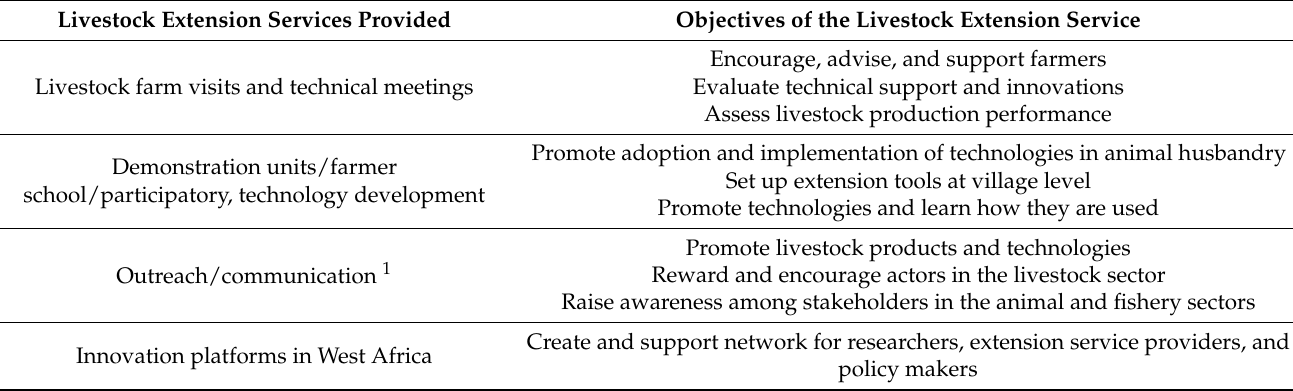
Table 5. Characteristics of the livestock extension services provided by extension and advisory institutions in Mali, Burkina Faso, and Benin contacted in this